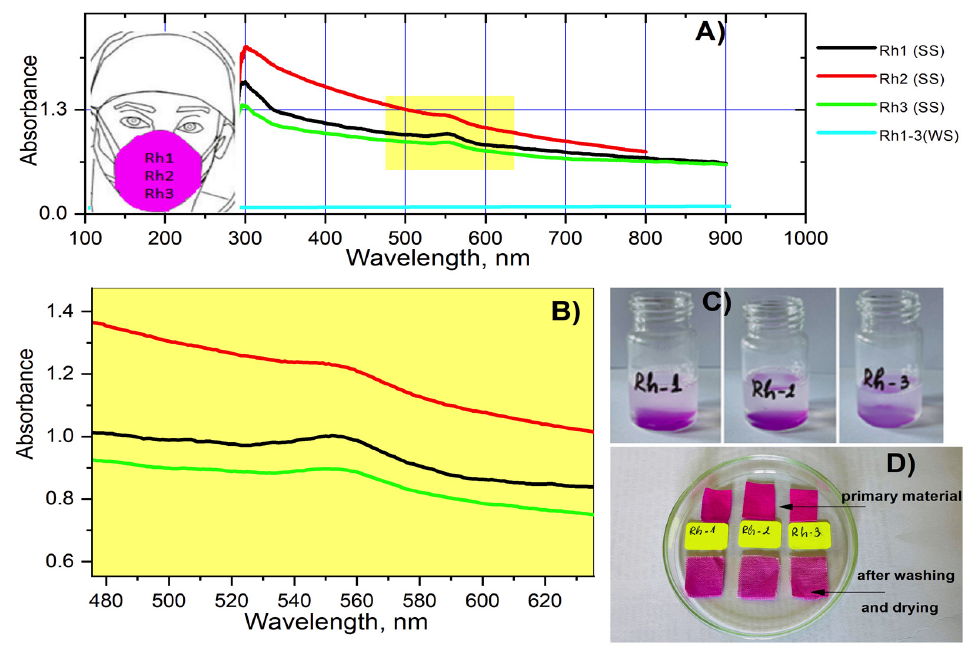
Figure 11. UV-Vis (zero) ( A ) and zoomed at 560 nm ( B ) spectra of soap (SS) and water (WS) solutions obtained after washing the materials; soap solutions immediately after washing the materials ( C ); compare the color of the material before and after washing with soap and water. The photos were taken after drying the materials ( D ). Table 2. Virucidal effect of new rhodamine B-conjugated hemorphin-4 analogues against human